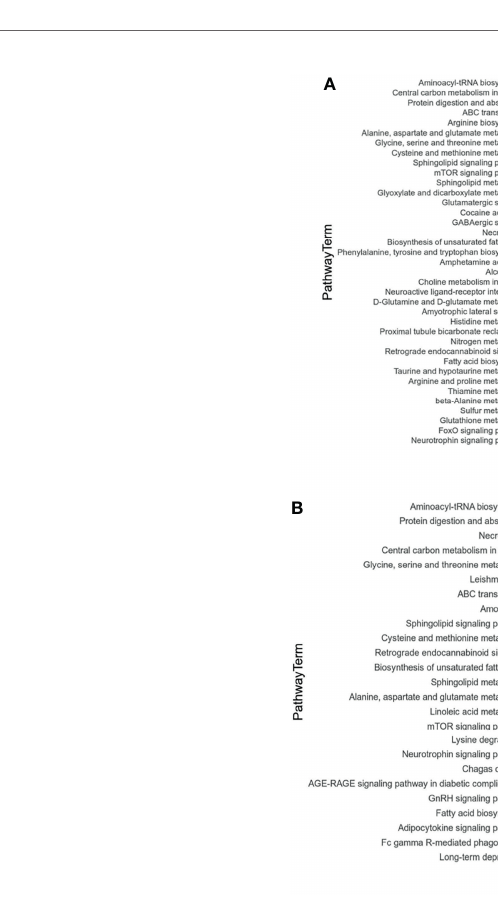
FIGURE 4 | KEGG enrichment of common regulated metabolites (A) Up-regulated metabolites; (B) down-regulated